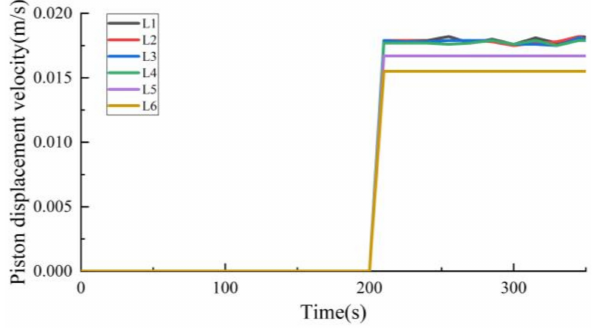
Figure 22. Piston speed of different leakage